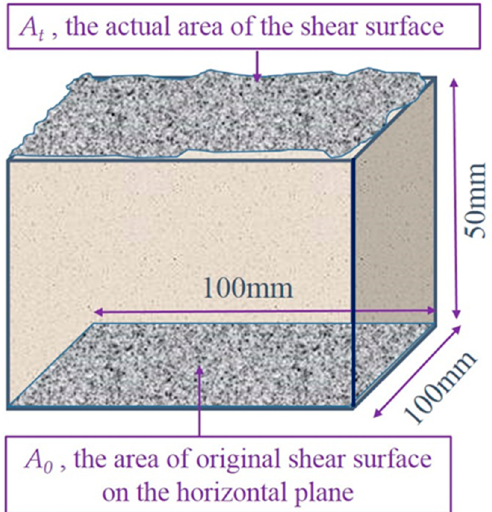
Figure 6. The Schematic diagram of A t and A 0 in joint shear